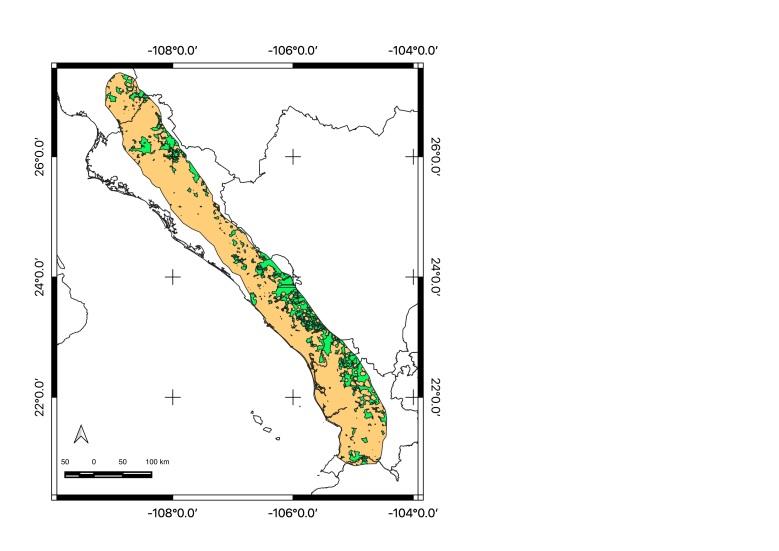
Habitat quality across the distribution of Brachypelma
emilia (White, 1856). Low quality habitat areas (LQH) in orange and high quality habitat areas (HQH) in green (for estimation details, see formula in Methods).